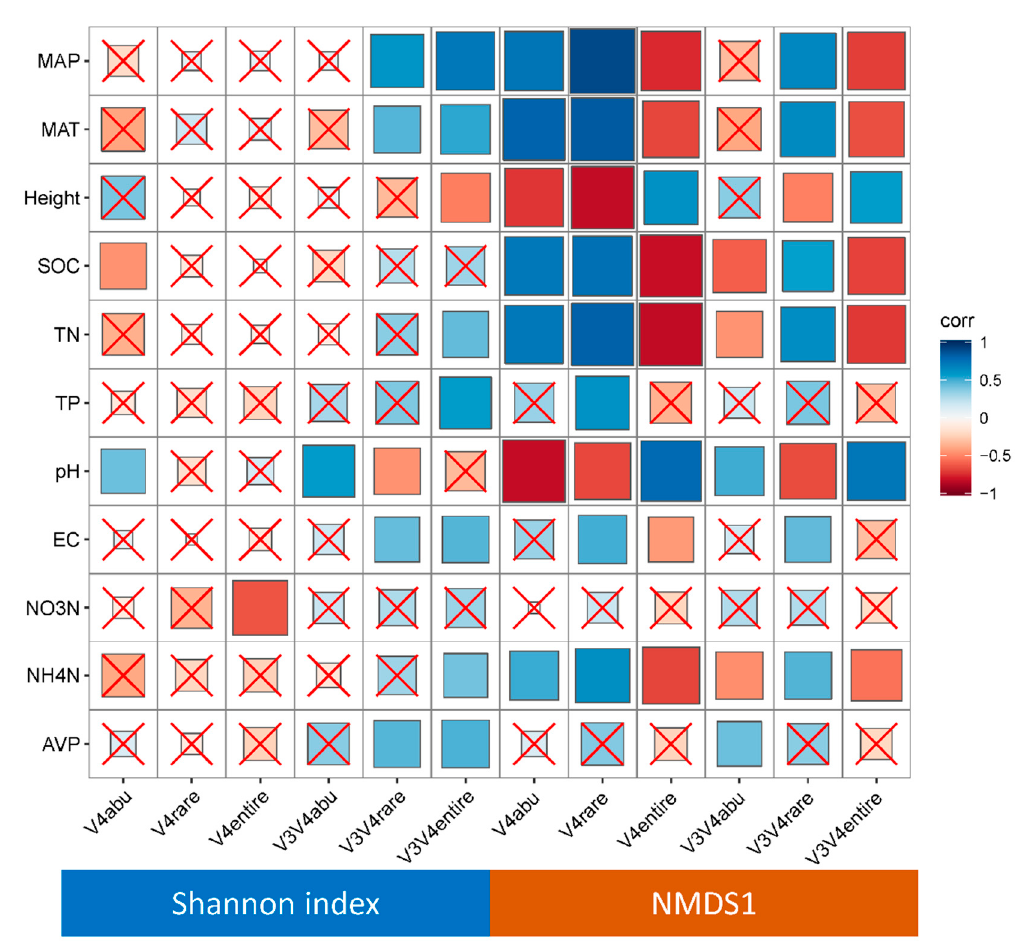
Figure 4. The associations between the diversity (Shannon index) and community structure (nonmetric multidimensional scaling 1 (NMDS1)) of abundant and rare soil bacteria in different land uses. Primer pair 520f/802r targeted the V4 region of the 16S rRNA gene; primer pair 338f/806r targeted the V3–V4 region of the 16S rRNA gene. The red crosses indicate nonsignificant correlations, and the size of the squares suggest higher Pearson coefficients. MAP, annual mean precipitation; MAT, annual mean temperature; SOC, soil organic carbon; EC, electrical conductivity; AVP, soil available phosphorus; TN, total nitrogen; TP, total phosphorous; NO3N, nitrate nitrogen; NH4N, ammonia nitrogen; abu, abundant bacterial taxa; rare, rare bacterial taxa; entire, the entire bacterial community.